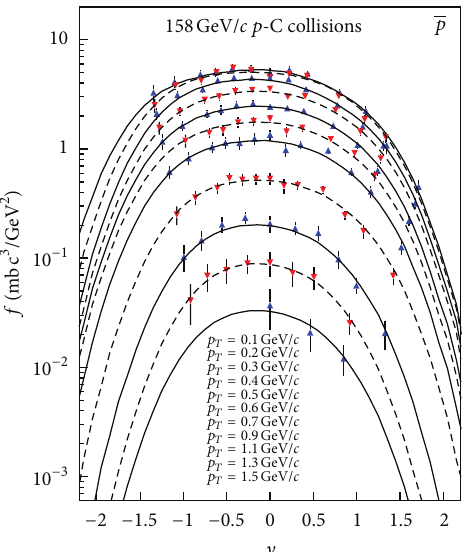
Figure 3: Rapidity distributions of antiprotons in 𝑝 -C collisions at 158 GeV/ c .ThesymbolsrepresenttheexperimentaldataoftheNA49 Collaboration [18] at different 𝑝 𝑇 , and the curves are our results calculated by the multisource thermal